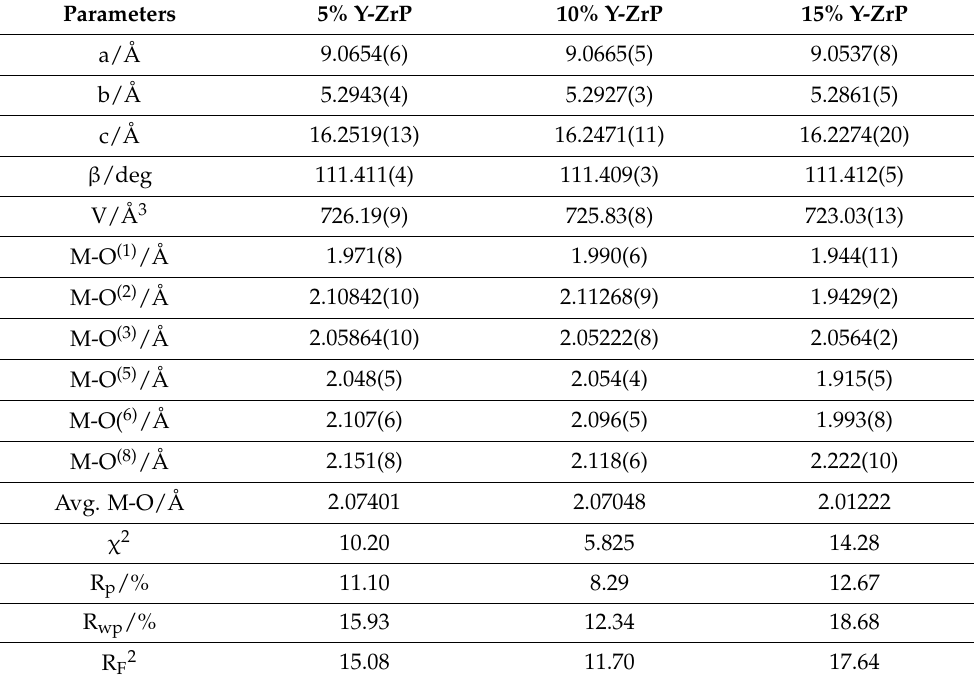
Table 6. Refined structural parameters for hydrothermally sinthesised